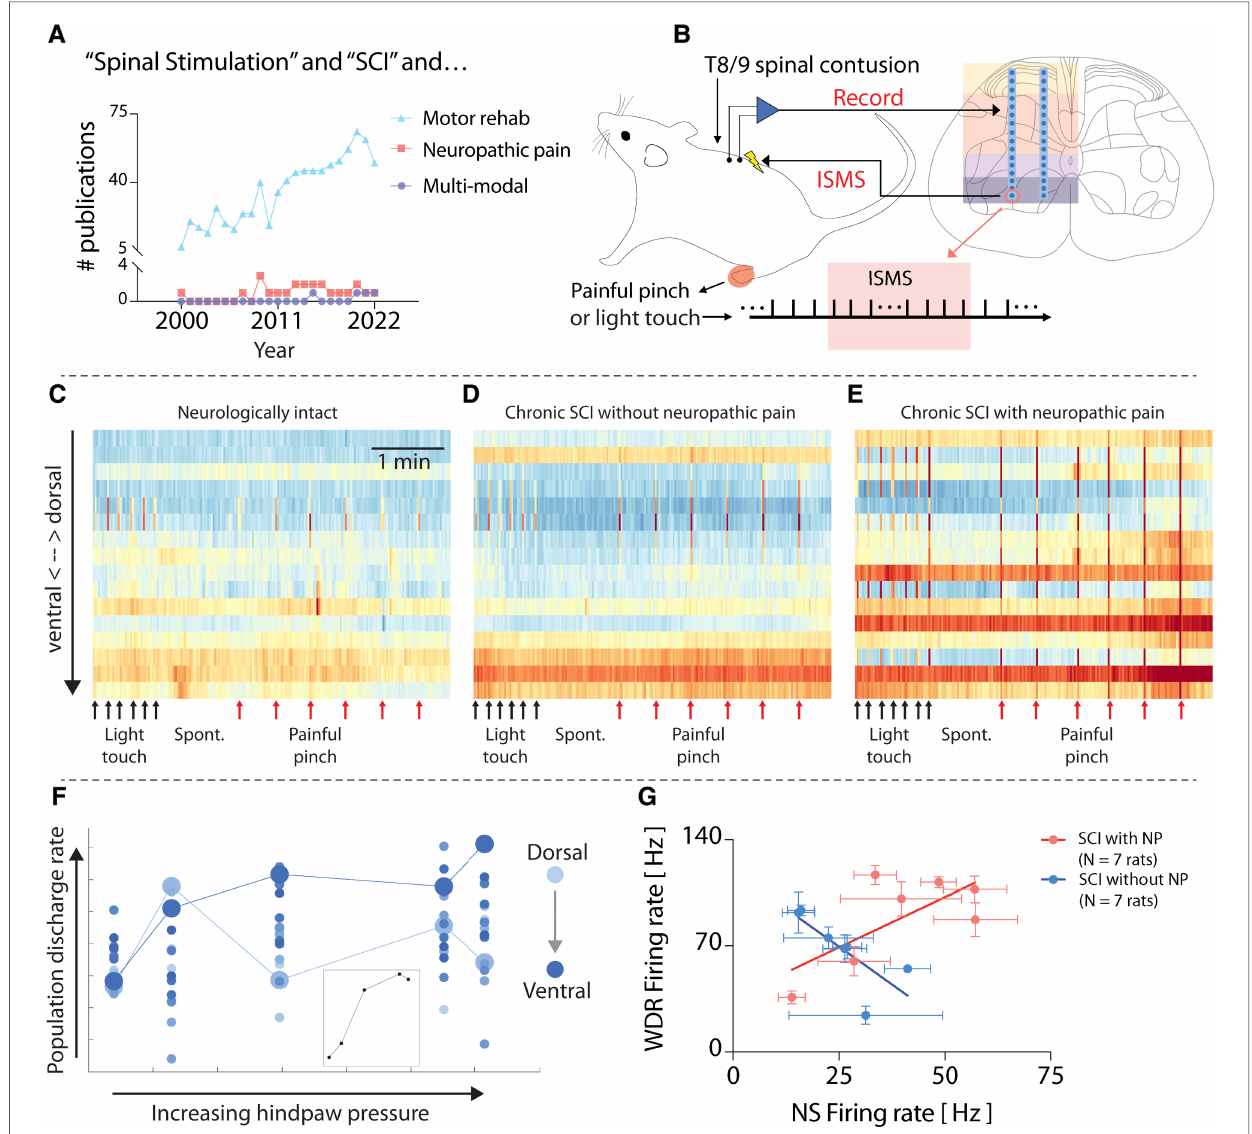
FIGURE 1 Heterogeneity in spinal responses to natural sensory feedback following spinal cord injury. ( A ) Results of a National Library of Medicine/PubMed database search for manuscripts related to spinal stimulation for sensorimotor consequences of SCI. Search terms: “ ((spinal cord injury[Title/Abstract]) AND (electrical spinal stimulation)) NOT (functional electrical stimulation[Title/Abstract]) AND (motor) ” ; “ ((spinal cord injury[Title/Abstract]) AND (Electrical spinal stimulation)) AND (neuropathic pain) ” ; “ ((spinal cord injury[Title/Abstract]) AND (electrical spinal stimulation)) AND (multimodal). ” ( B )